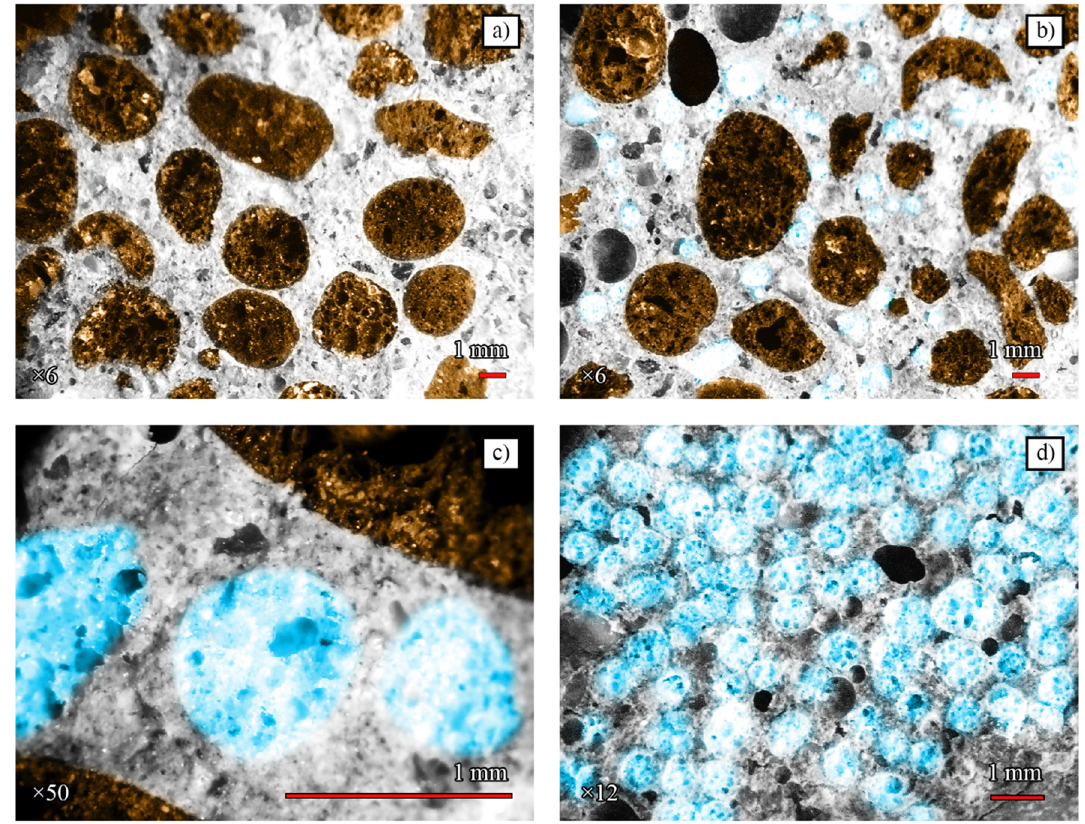
Figure 4. Microscopic photographs of specimens after splitting test (EGA highlighted in blue): ( a ) EGA0; ( b ) and ( c ) EGA5; ( d ) EGA100.